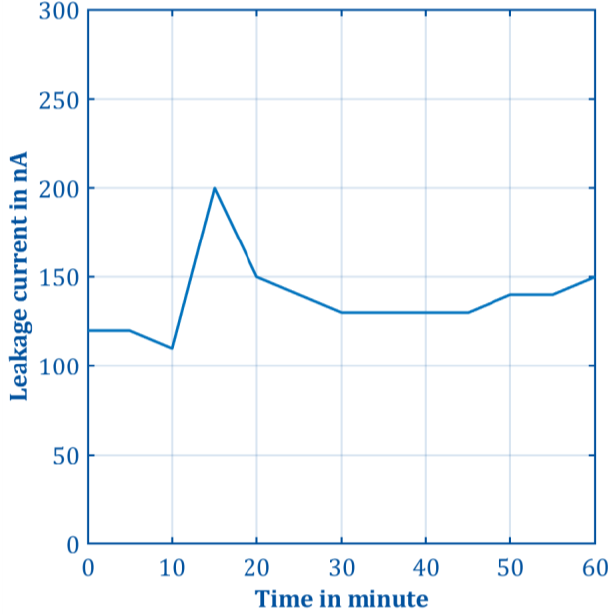
Figure 7. Measurement of leakage current through the isolated DC power supply over one hour. The measured leakage current is within the resolution range of the high-voltage power supply over the entire measured time and does not exceed 200 nA; therefore, the isolation resistance is above 250 GΩ.